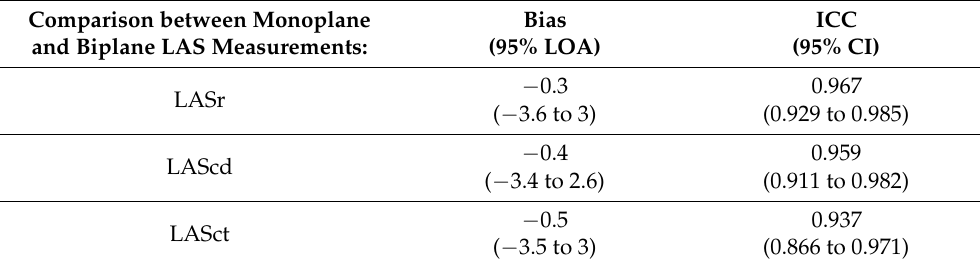
Table 2. Comparison between monoplane LAS measurements from a single apical 4-chamber view and biplane LAS measurements form an apical 4- and 2-chamber view.